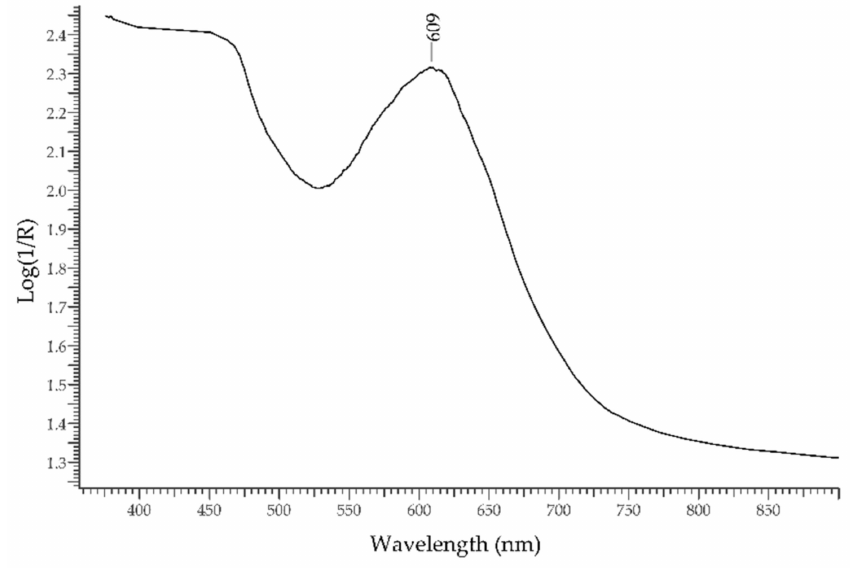
Figure 8. FORS spectrum in Log(1/R) coordinates of